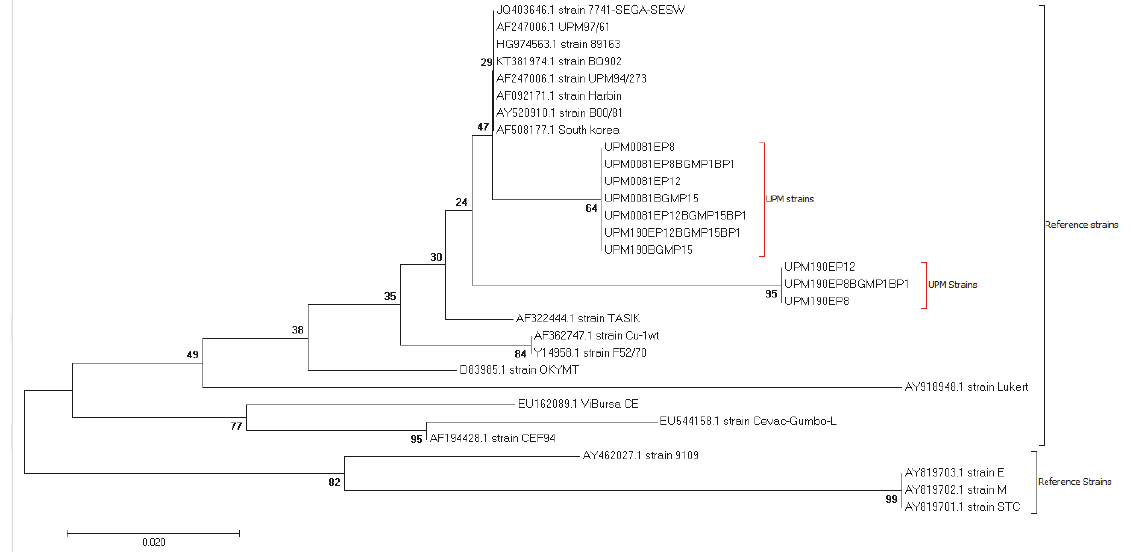
Figure 6: Phylogenetic analysis of bioreactor, CAM adapted, and conventional flask propagated UPM0081 and UPM190. Phylogenetic relationship of taxa between bioreactor, BGM-70, and CEE passaged UPM190 and UPM0081 isolates with reference sequences to determine their phylogenetic relationship. The evolutionary history was inferred using the Neighbor-Joining method with bootstrap (1000 replicates). The evolutionary distances were computed using Poisson correction method. The analysis involved 30 amino acid sequences with a total of 80 positions. The analyses were conducted in MEGA7. Note that the UPM strains formed 2 distinct clusters within the vvIBDV branches from the reference sequences indicating their close